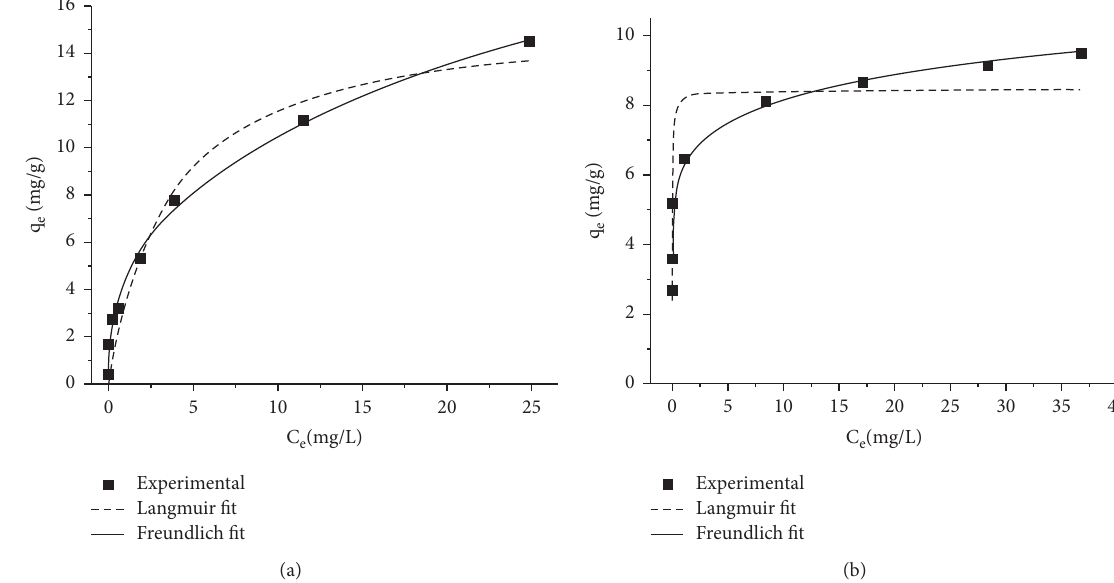
Figure 10: Langmuir and Freundlich isotherm model for the adsorption of Cr(VI) onto (a) TR and (b) PSS. Table 3: Isotherm parameters of the adsorption of Cr(VI) on TR and PSS.